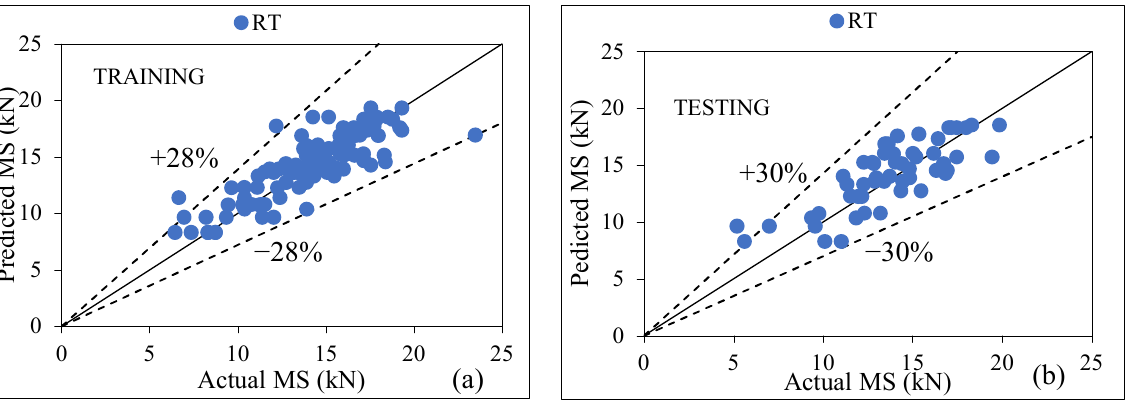
Figure 8. ( a , b ). Agreement graph showing actual vs. predicted values of MS by using an RT-based